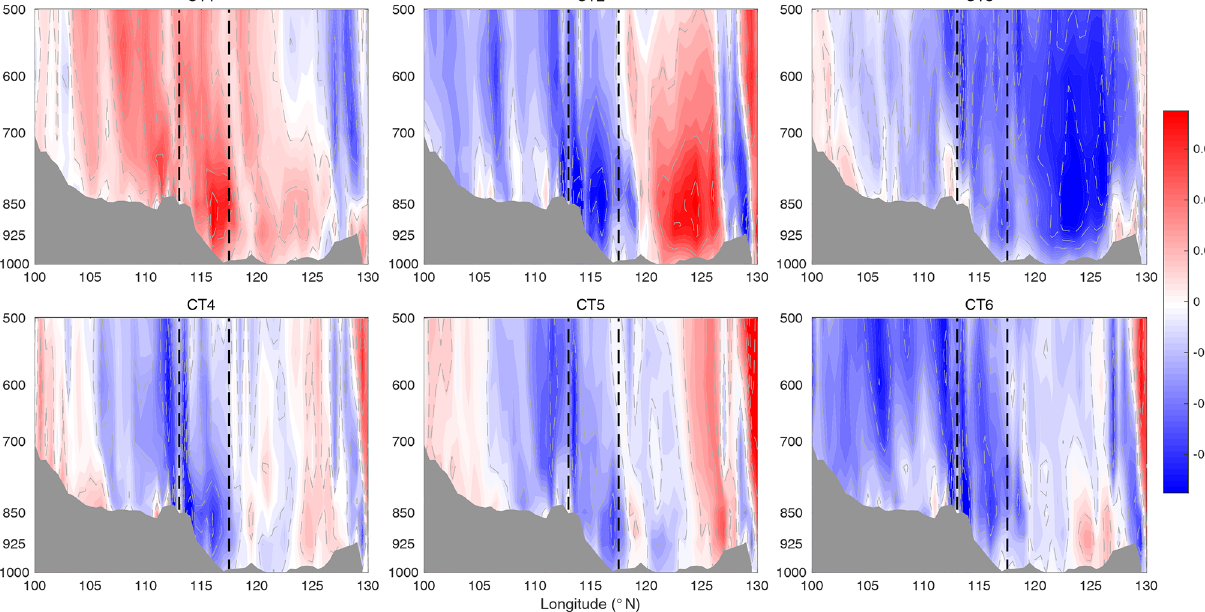
Figure 6. Zonal vertical profile of vertical velocity anomaly over BTH region (unit: Pas − 1 ). The anomaly of the vertical velocities is with respect to the 1980 to 2010 mean